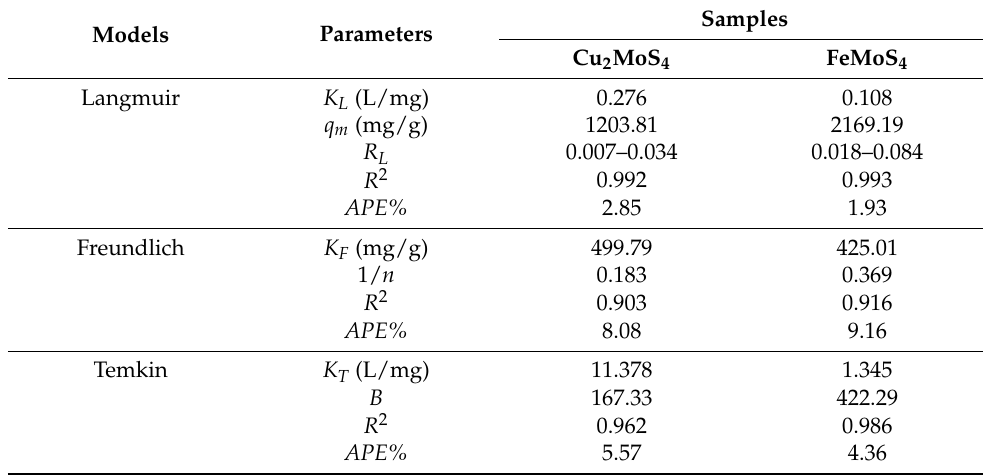
Table 2. Adsorption isotherm parameters for CTC onto Cu 2 MoS 4 and FeMoS 4 .